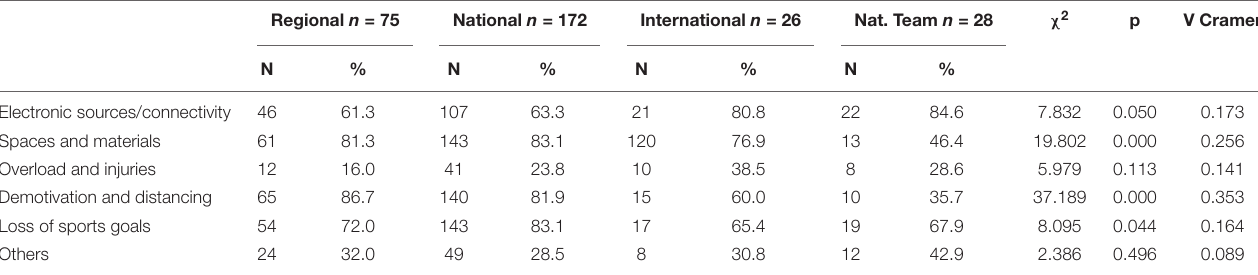
TABLE 6 | Determinants of gymnasts’